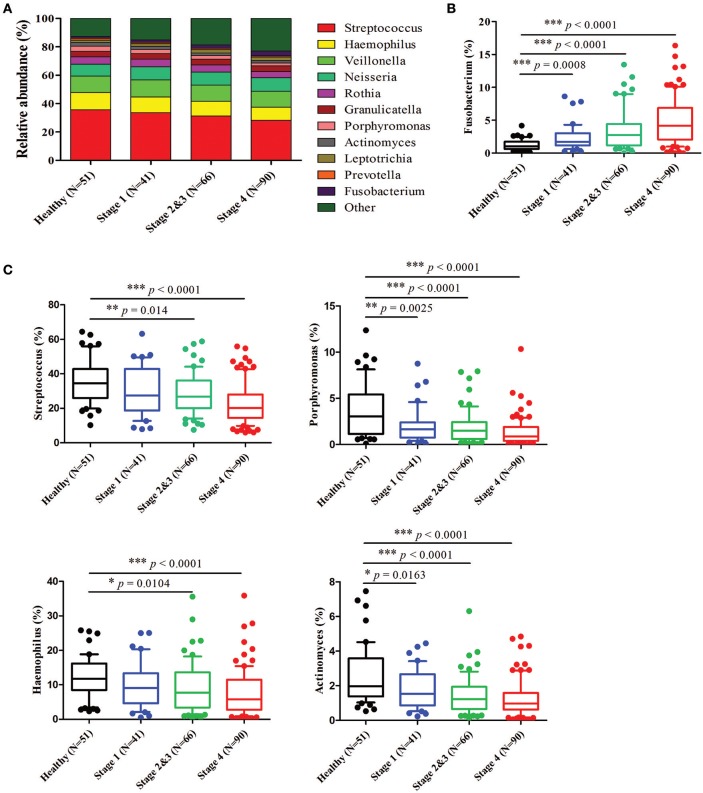
Relative abundance of the most prevalent genera in healthy and OSCC patients. Bacteria taxonomic profiling at the genus level of the oral microbiome from healthy controls and OSCC patients. (A) The 11 bacteria at the genus level in the oral microbiome. The box plots show the relative abundance of Fusobacterium
(B) and Streptococcus, Haemophilus, Porphyromonas, and Actinomyces
(C) in healthy controls and OSCC patients. Horizontal lines represent mean values. p < 0.05 indicates statistical significance using a nonparametric Mann-Whitney U test.